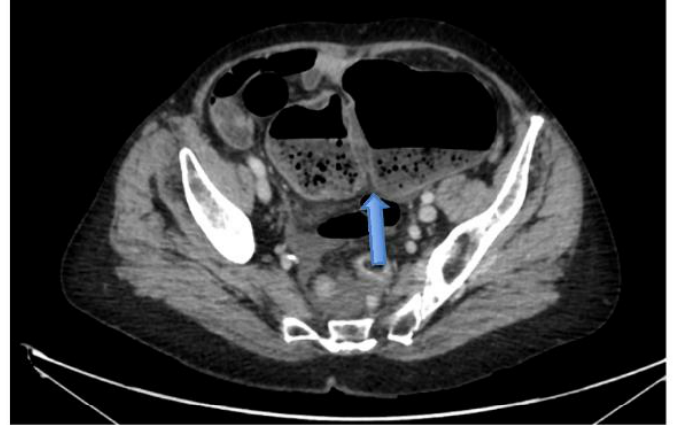
Figure 8. CT Axial image demonstrating the ‘split-wall sign’ (blue arrow).